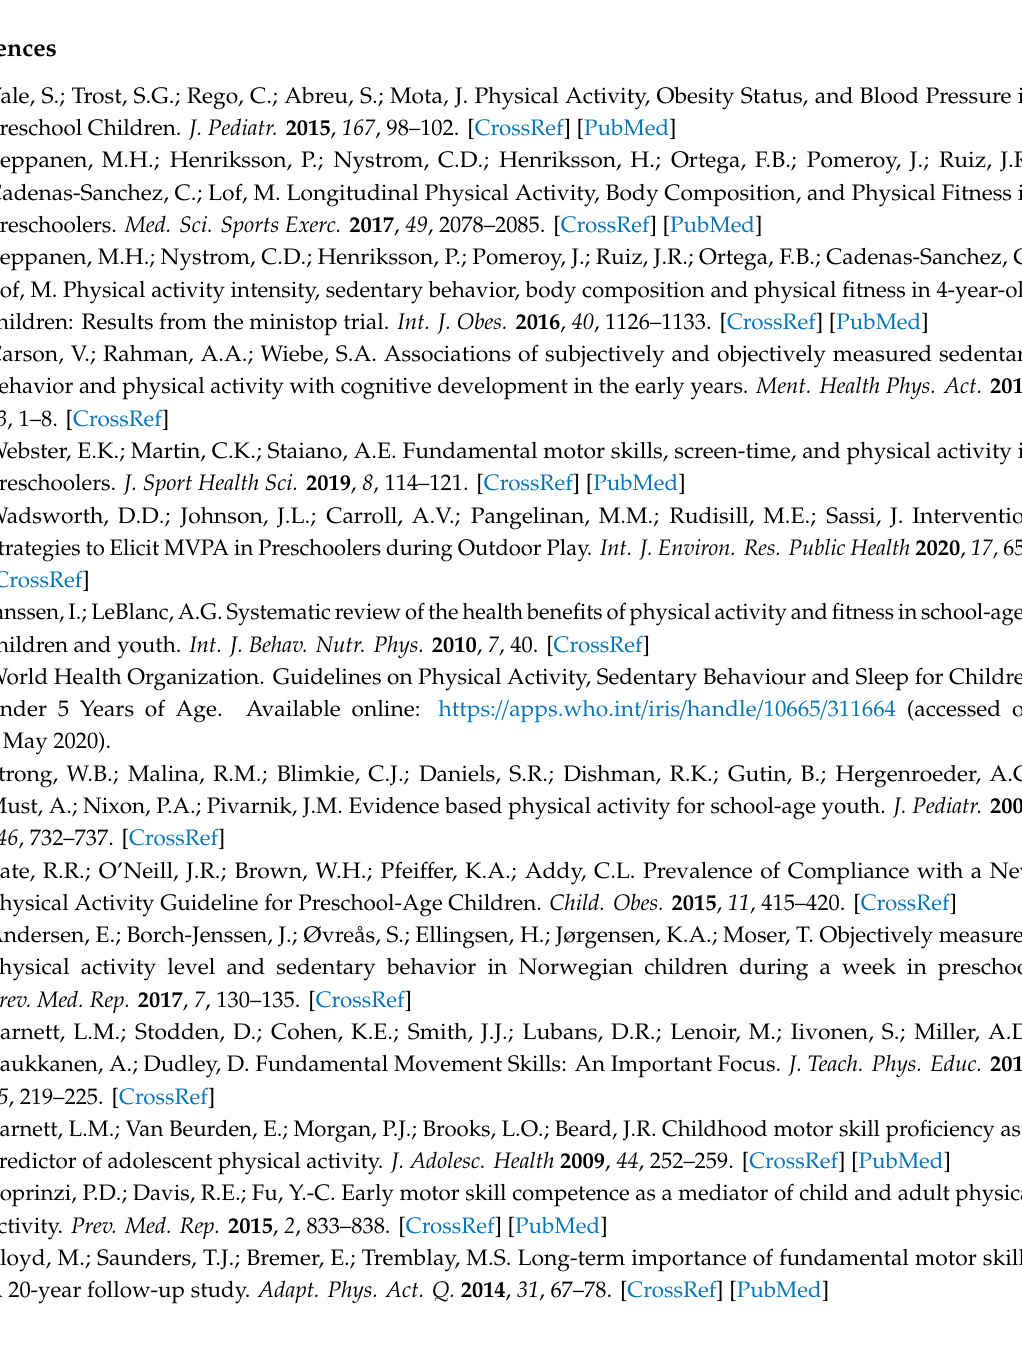
Table S1: Search strategies used for each